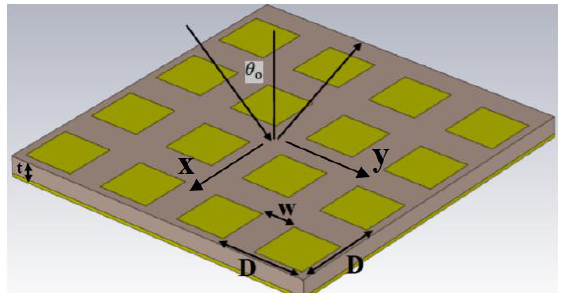
Figure 2: Geometry of scattering by periodic patched on a grounded dielectric